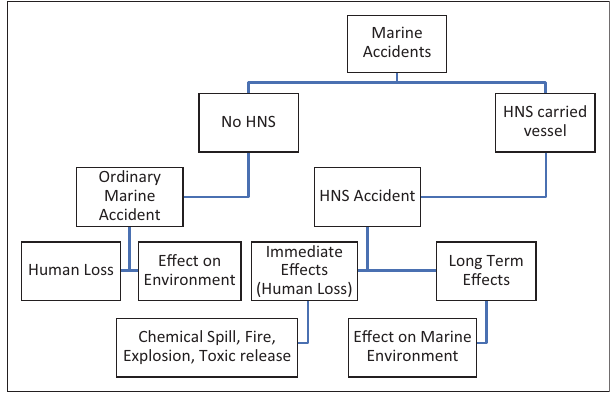
FIGURE 1: Effect of marine accidents involving vessels carrying hazardous and noxious